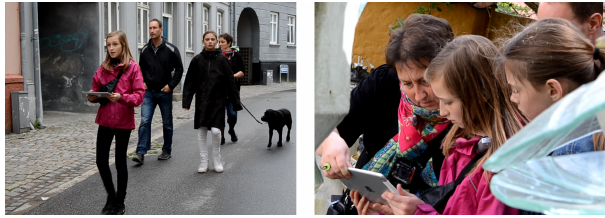
Figure 7. Childin chargeof the iPad (left) and parentassisting the